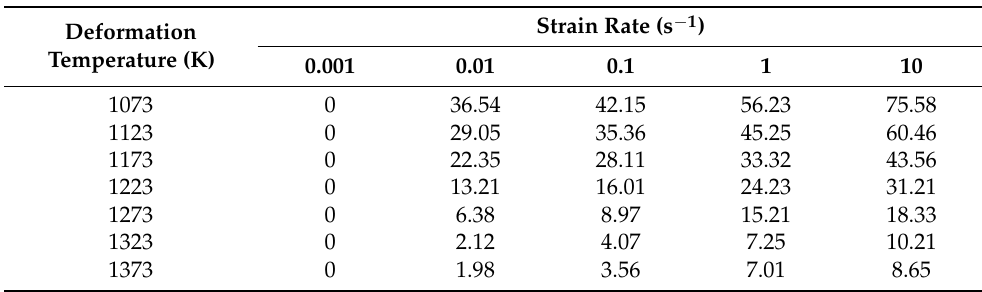
Table 2. Deformation heating effect—the temperature rise (K) of the material under different defor- mation conditions.